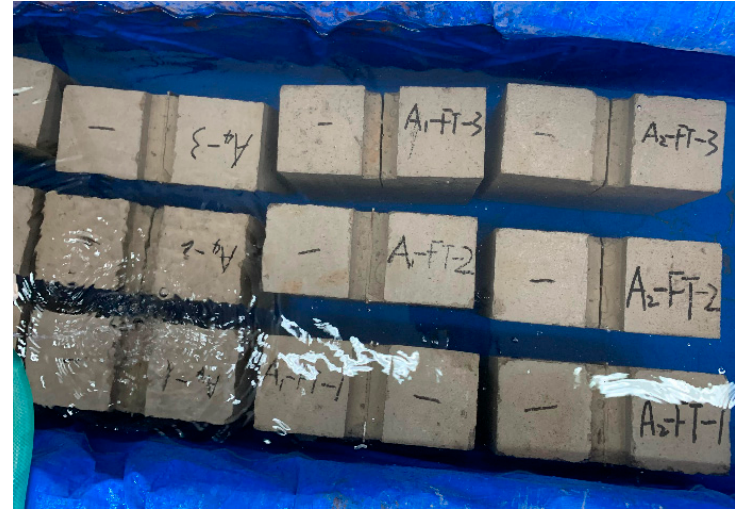
Figure 3. The concrete specimens were soaked in a watery environment.